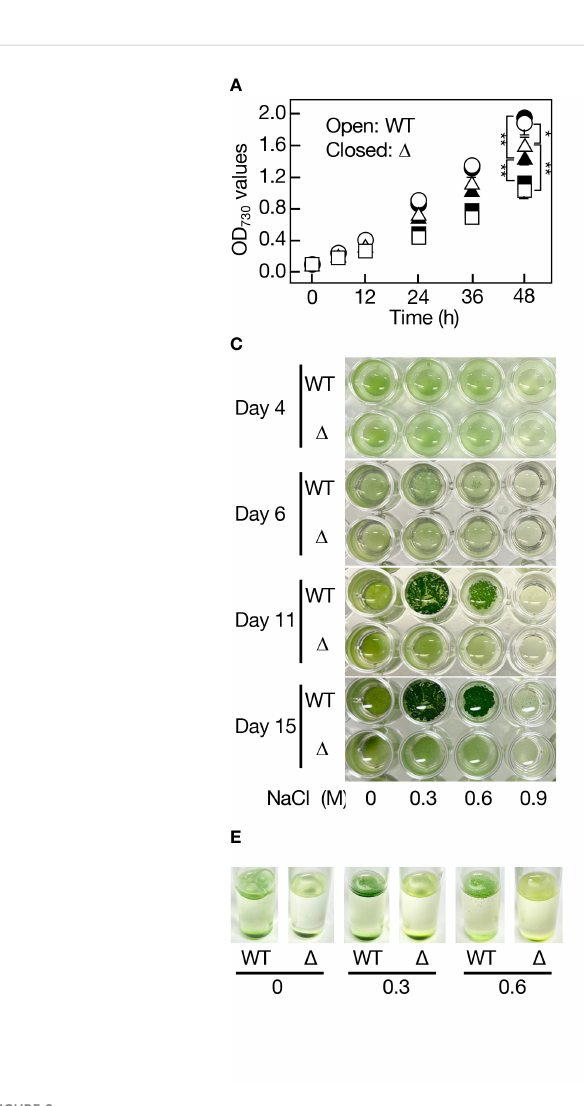
FIGURE 8 Contribution of slr2103 to cell growth in Synechocystis in a static culture and its enhancement under saline stress conditions. (A) Effects of NaCl- stress on cell growth in the WT (open symbols) and D slr2103 (closed symbols) in bubbling aeration cultures. Circles, 0 M NaCl. Triangles, 0.3 M NaCl. Squares, 0.6 M NaCl. (B) Cell growth of D slr2103 in a static culture. Photographs of microtiter plates where the WT and D slr2103 cells were statically cultured with or without NaCl stress at 0.3 to 0.9 M (C) , and concomitant monitoring of cell growth based on the Chl content (D) . Open and closed bars correspond to the non- fl oating ( NF ) and fl oating ( F ) cells, respectively. (E) Photographs of test tubes where the WT and D slr2103 cells were statically cultured for 9 days with 0-0.6 M NaCl stress. (F) Quantitative behavior of lipid X relative to total lipids in statically cultured Synechocystis cells for 15 days with or without NaCl stress at 0.6 M, which was estimated as in Figure 1F. Indicated are the values for total ( T ), F or NF cells. Red dotted line, initial lipid X content in aeration-cultured cells before the shift to static conditions. The values shown are averages ± SD for three experiments. The signi fi cance of differences was evaluated by Student ’ s t -test. *P < 0.1.